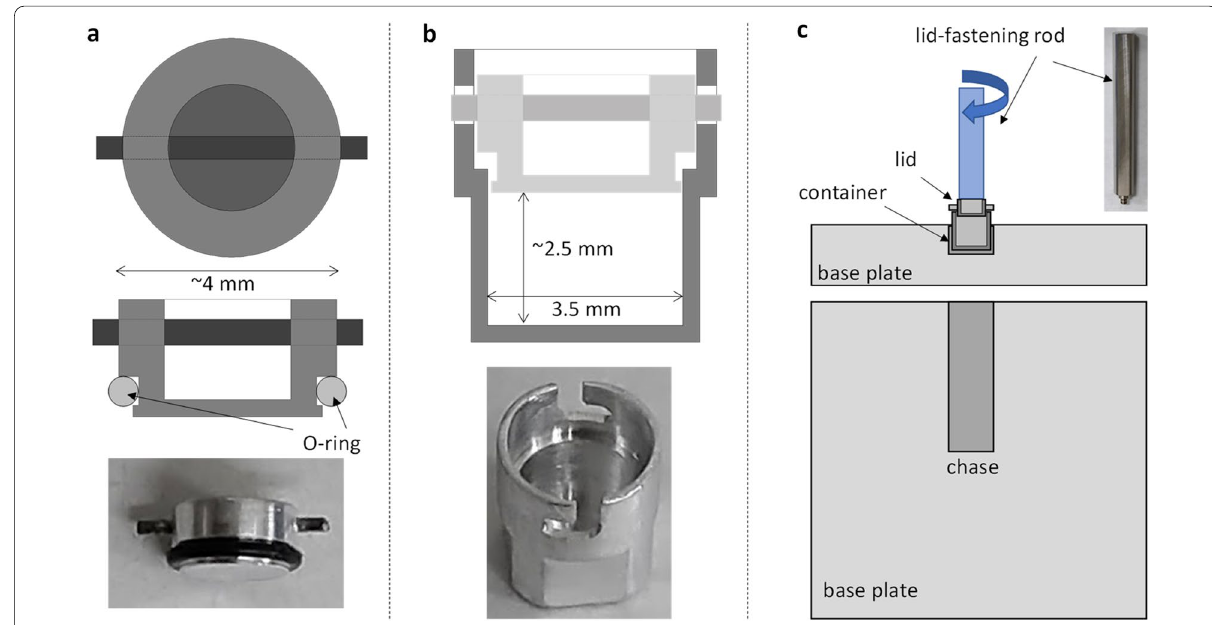
Fig. 11 Schematic diagrams and photographs of the weighing container. a . The lid has an elastomeric O ring. b . The container has an inner space of 3.5 mm in diameter and ~ 2.5 mm in height. c . The container can be fasten with one hand by using the base plate and the lid-fastening rod